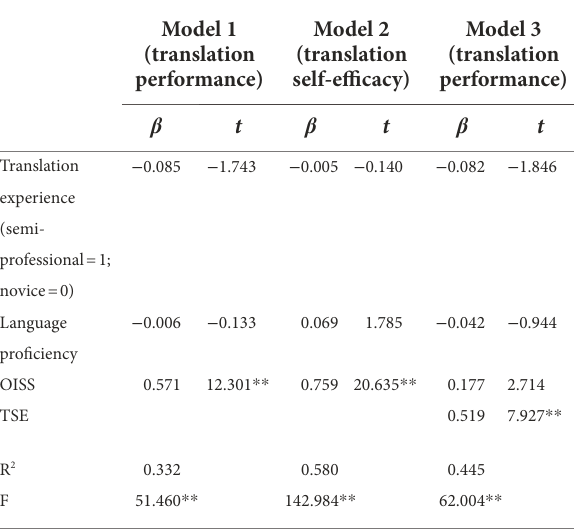
TABLE 3 Mediation effects of translation self-efficacy on the relationship between online information seeking and translation